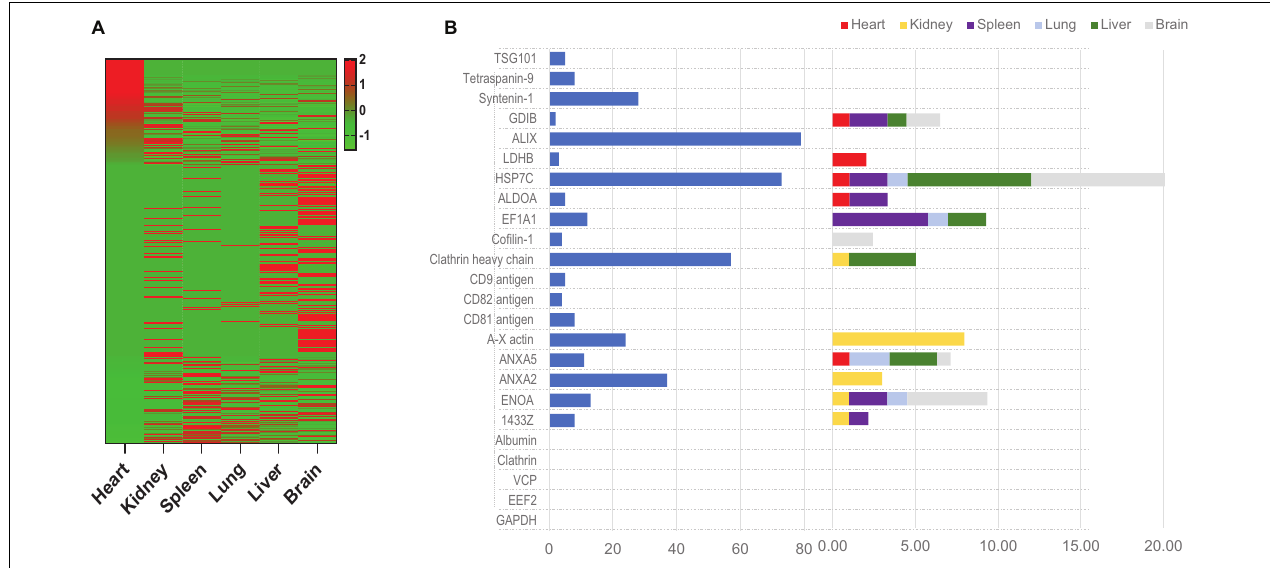
FIGURE 4 | Proteins from systemically administered MetRS ∗ MSC-Exos can be detected, identified, and quantified in mouse organs via click-catalyzed alkyne-agarose capture. MetRS ∗ MSC-Exos were injected into the tail vein of mice. Animals were euthanized 24 h later, and protein extracts were prepared from the heart, kidney, spleen, lung, liver, and brain; then, proteins from the MetRS ∗ MSC-Exos (i.e., those containing the ANL label) were isolated via click-catalyzed alkyne-agarose capture and identified via LC-MS. (A) MetRS ∗ MSC exosomal proteins isolated from the indicated organs (average total spectra) were presented as a heat map. (B) The abundance of canonical positive and negative exosome marker proteins was quantified in MetRS ∗ MSC-Exos before injection (left) and in the indicated organs of mice after MetRS ∗ MSC-Exo injection (right).